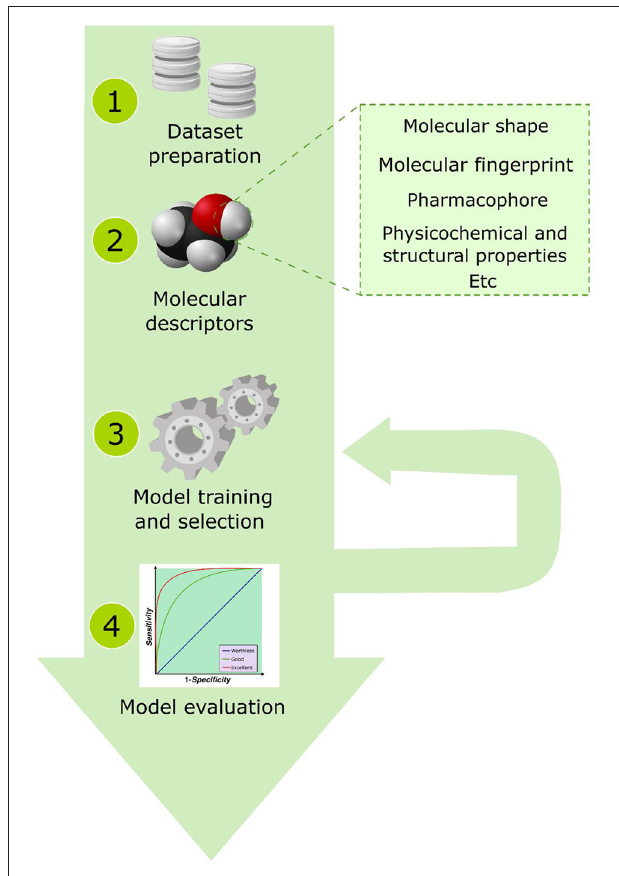
FIGURE 6 | A general overview of the computational steps involved in obtaining a validated supervised machine learning algorithm.